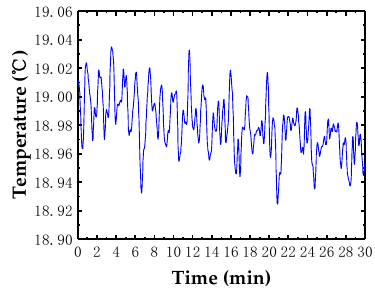
Figure 11. Temperature in the chamber.